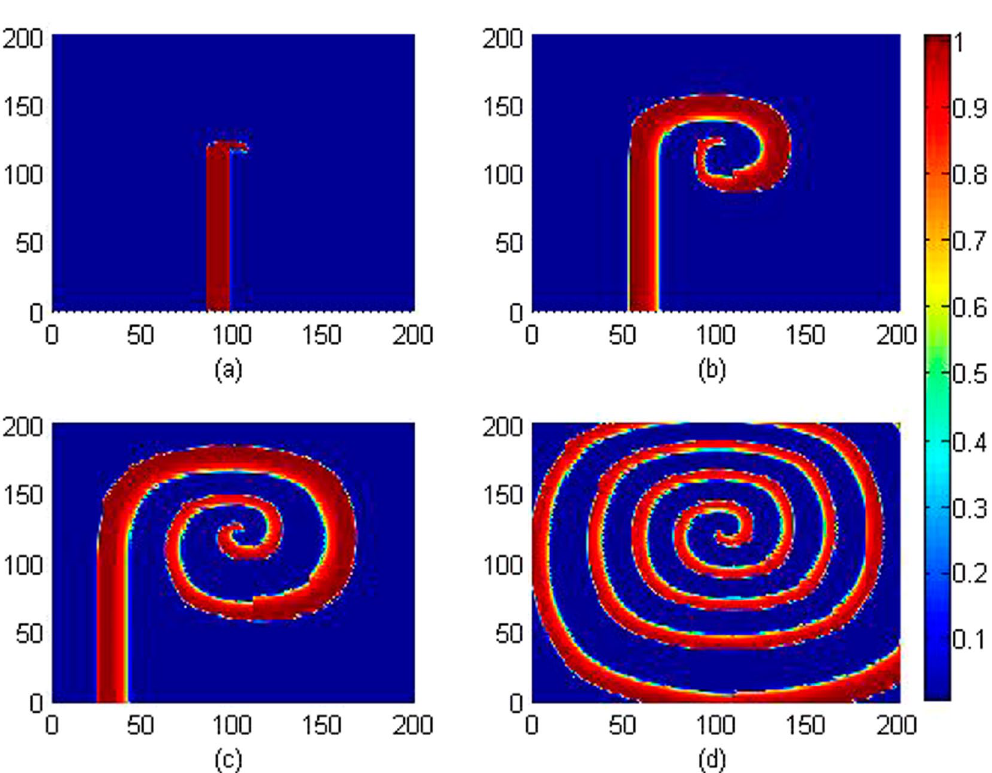
Figure 8. Developed spatial pattern is plotted for the media at t = 10, 60, 100, 200 time units under feedback gain k 2 = 3.0, at k 0 = 0.1, k 1 = 0.5, α = 1, β = 2. The snapshots are shown color